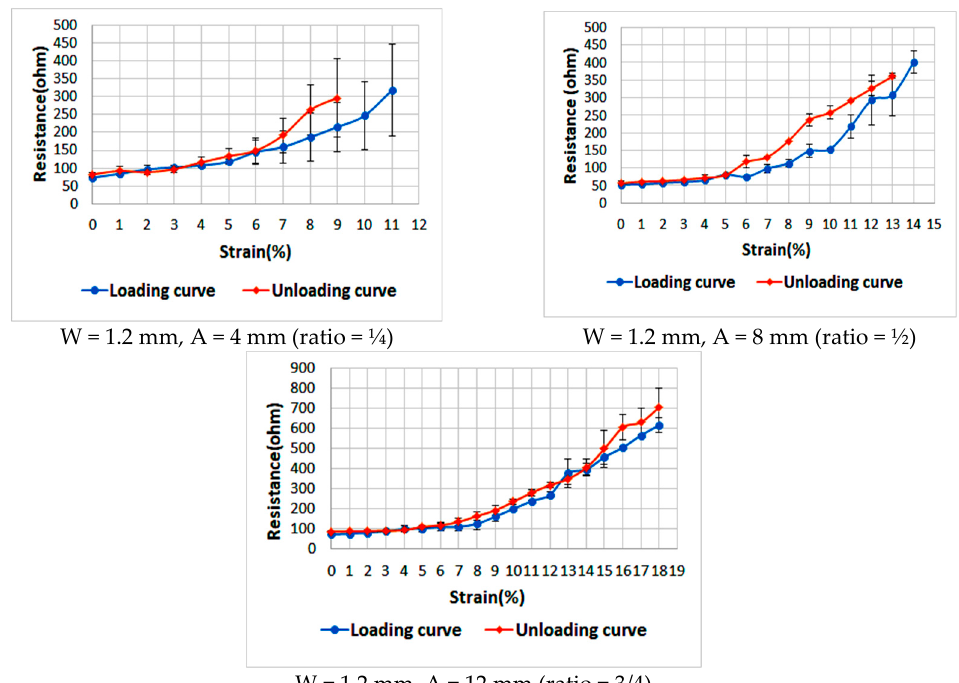
Figure A2. Average resistances of two sinusoidal samples at a width of 1.2 mm and various amplitudes as the applied strain increases (loading) and decreases (unloading). Error bars indicate the standard deviation in the values of the resistances.